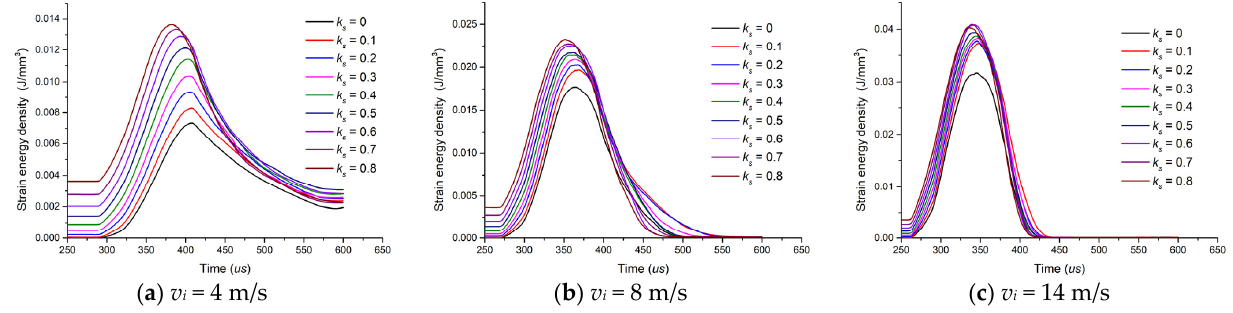
Figure 5. The curves of strain energy per unit volume vs. k s for coal specimens subjected to different pre-stress levels and impact speeds.